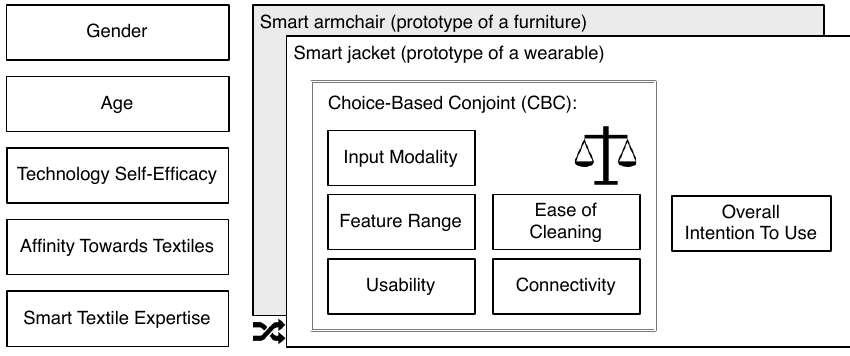
Figure 1. Design of the survey to study the individual weightings of product properties for two different smart textile